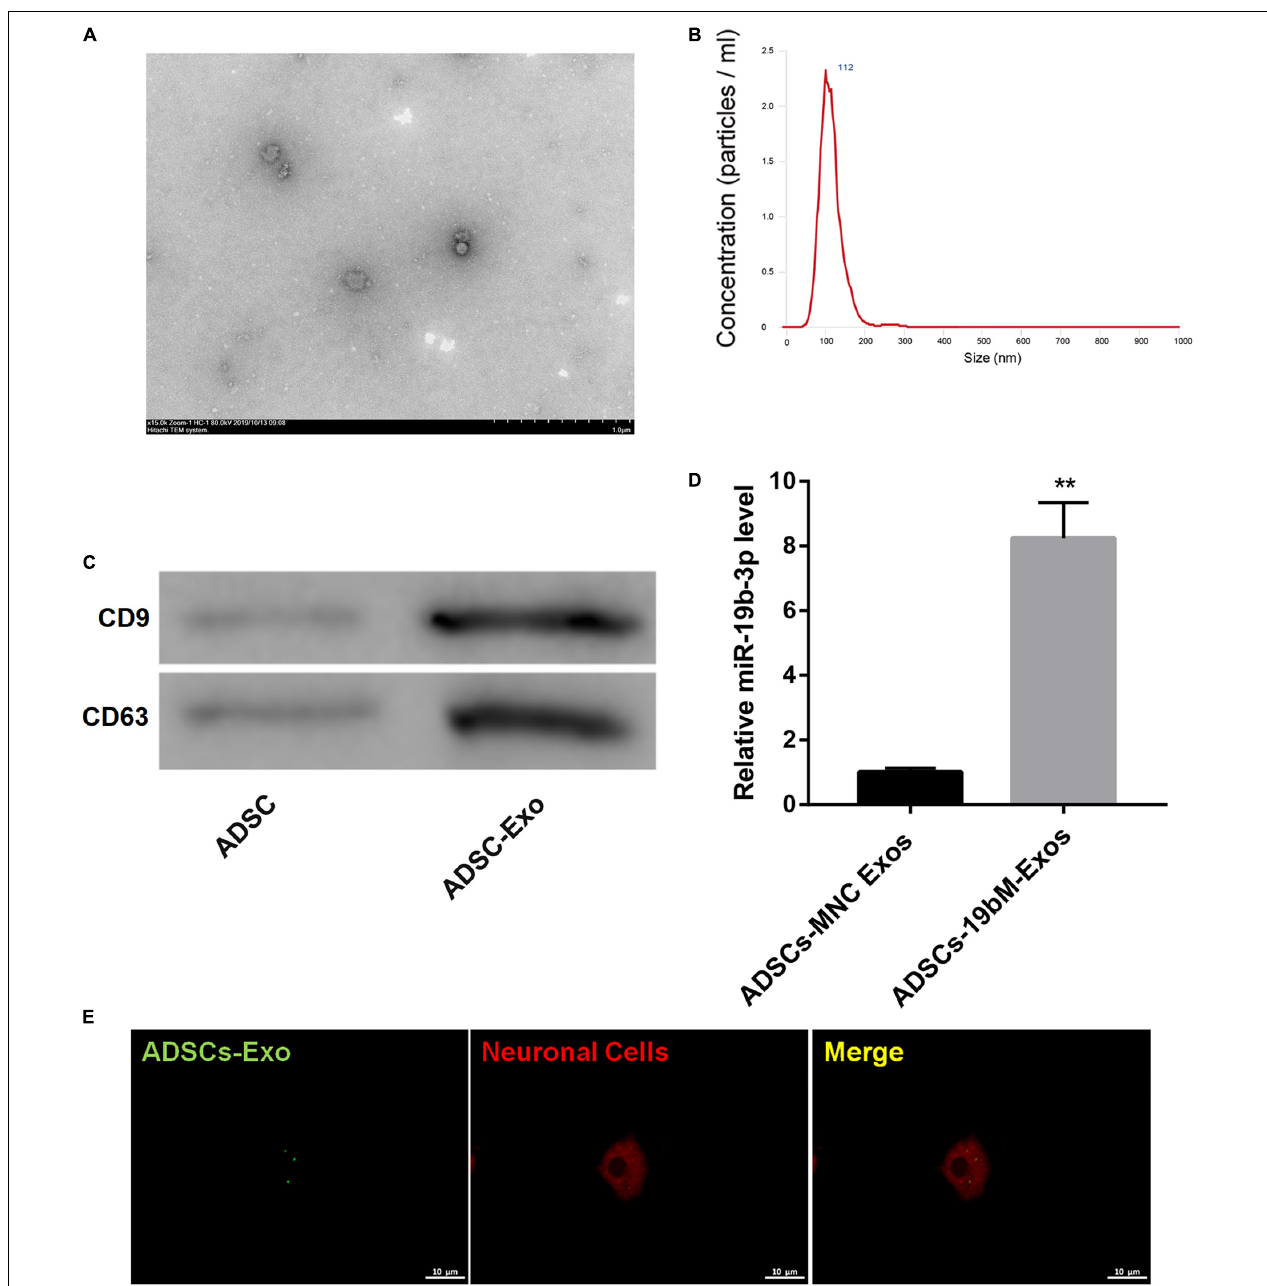
FIGURE 3 | Identification of ADSCs-Exos. (A) The morphologic characteristics of ADSCs-Exos were observed by TEM. (B) The size distribution of exosomes was evaluated using nanoparticle tracking analysis. (C) The protein levels of exosomal surface markers (CD9 and CD63) were examined by western blot. (D) miR-19b-3p level in ADSCs-MNC-Exos and ADSCs-19bM-Exos was examined by qRT-PCR. (E) The uptake of DiO-labeled ADSCs-Exos (green) by Dil-labeled neuronal cells (red) was observed by laser confocal microscopy. The data are presented as the mean ± standard deviation ( n = 3). ** P < 0.01, vs. ADSCs-MNC-Exos.